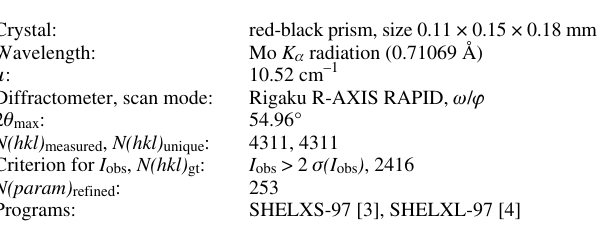
Table 1. Data collection and handling.